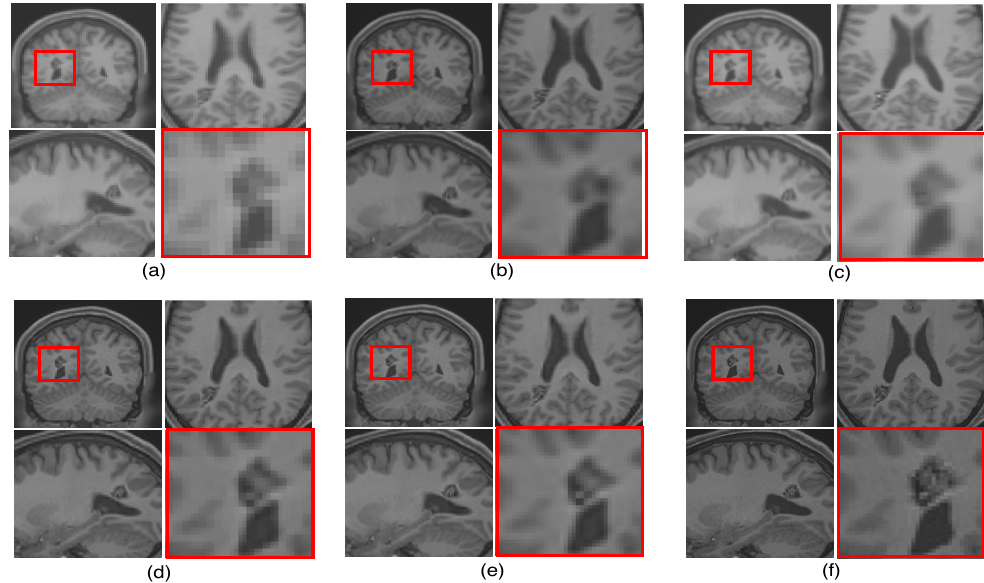
Figure 11. Illustration of super resolution results for structural deformity cavernoma in real MR images, by different algorithms: ( a ) nearest neighbor, ( b ) spline interpolation, ( c ) non local means in three dimensions (NLM3D) [13], ( d ) low rank total variation based method (LRTV) [12], ( e ) the proposed approach, and ( f ) the original HR image. Each slice in axial, sagittal, and coronal planes is shown. The zoomed version of the cavernoma region from the coronal slice is highlighted in red rectangle. Please zoom for better visualization.